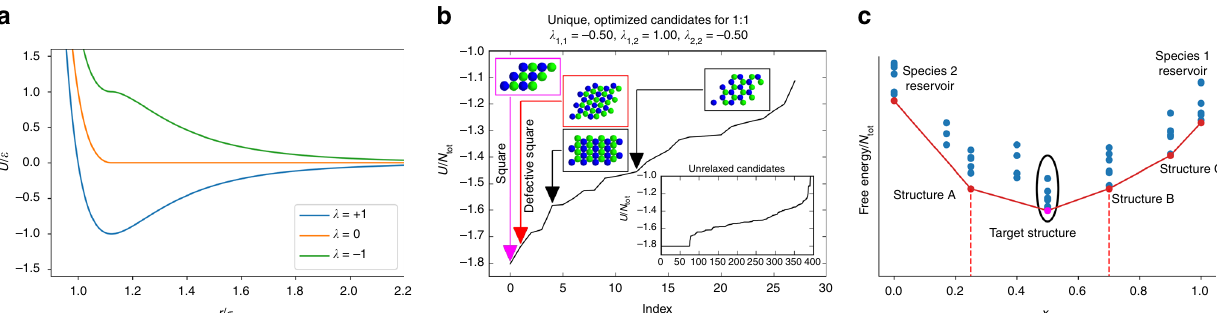
Fig. 3 Construction of phase diagrams. a Potential energy function used in this work for representative values of the parameter λ . b Results of basin hopping (stochastic) optimization of an initial set of 25 candidates (inset) from each of the 16 groups considered, with a 1:1 stoichiometry. The main panel shows the speci fi c energy of each structurally unique fi nal candidate found, representing distinct local minima in energy. Several representative images are also shown. c Schematic of a representative convex hull (in red) showing thermodynamically stable structures on the hull as well as metastable structures (blue points). The ellipse encircles the points that result from the basin hopping stage as in b , with the magenta point corresponding to the ground